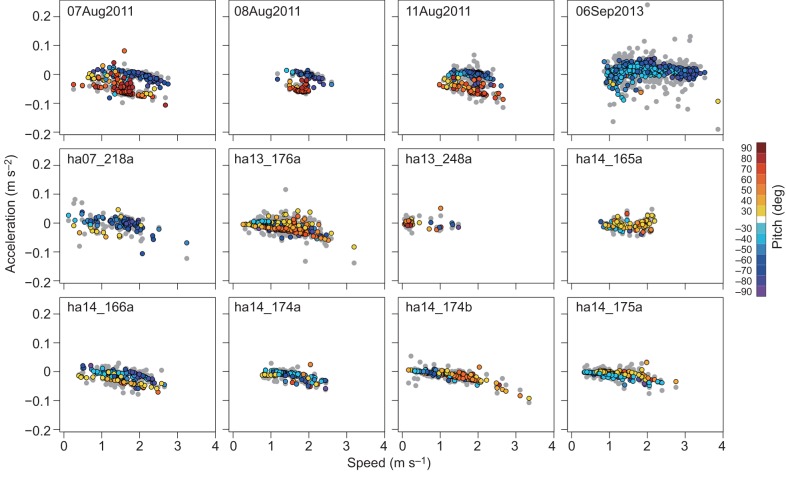
Acceleration versus speed for each glide. Observed acceleration is shown as gray circles. Posterior mean modelled acceleration is shown as colored circles; the color of each data point indicates the pitch angle recorded during the glide segment.